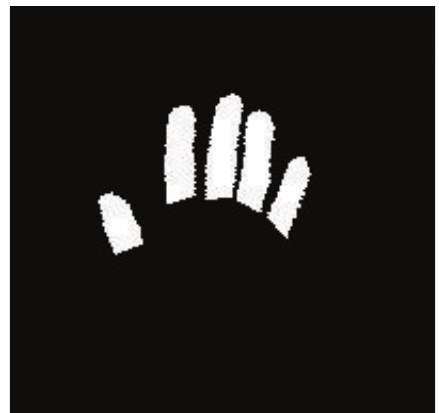
Figure 9: The segmented fingers.